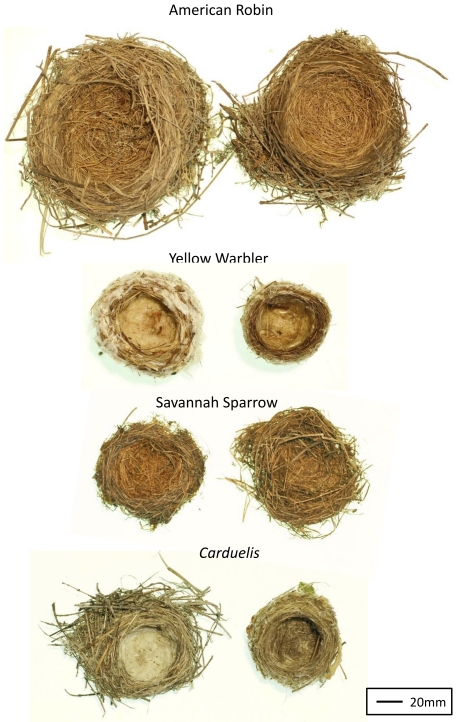
Photographs of nests illustrating visible differences in nest morphology and composition.Representative nests from northern Manitoba (left) and southeastern Ontario (right) for American Robin, Yellow Warbler, Savannah Sparrow, and Carduelis finches (Common Redpoll on left and American Goldfinch on right). Note that the shape and morphology of the Savannah Sparrow nests are distorted because they are ground nests that lose their structure when removed from the nest site.